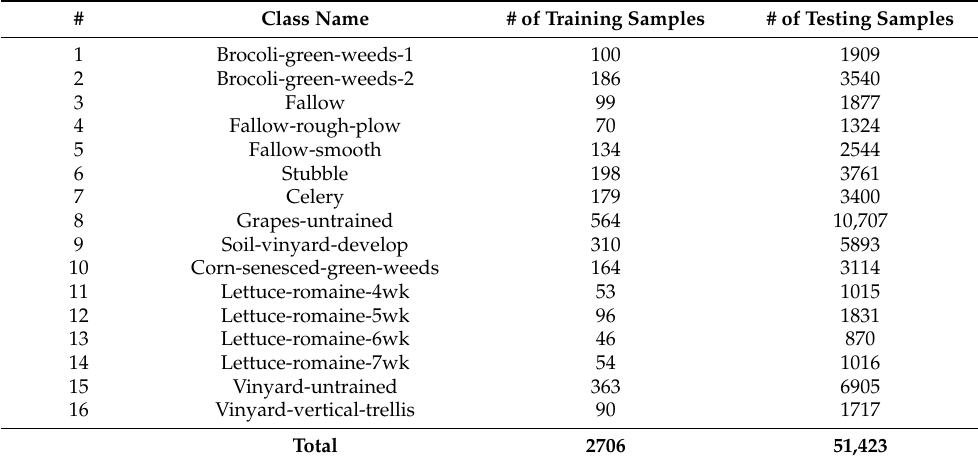
Table 1. Total number of class-specific training and testing samples used for a Salinas dataset for 5% training data.